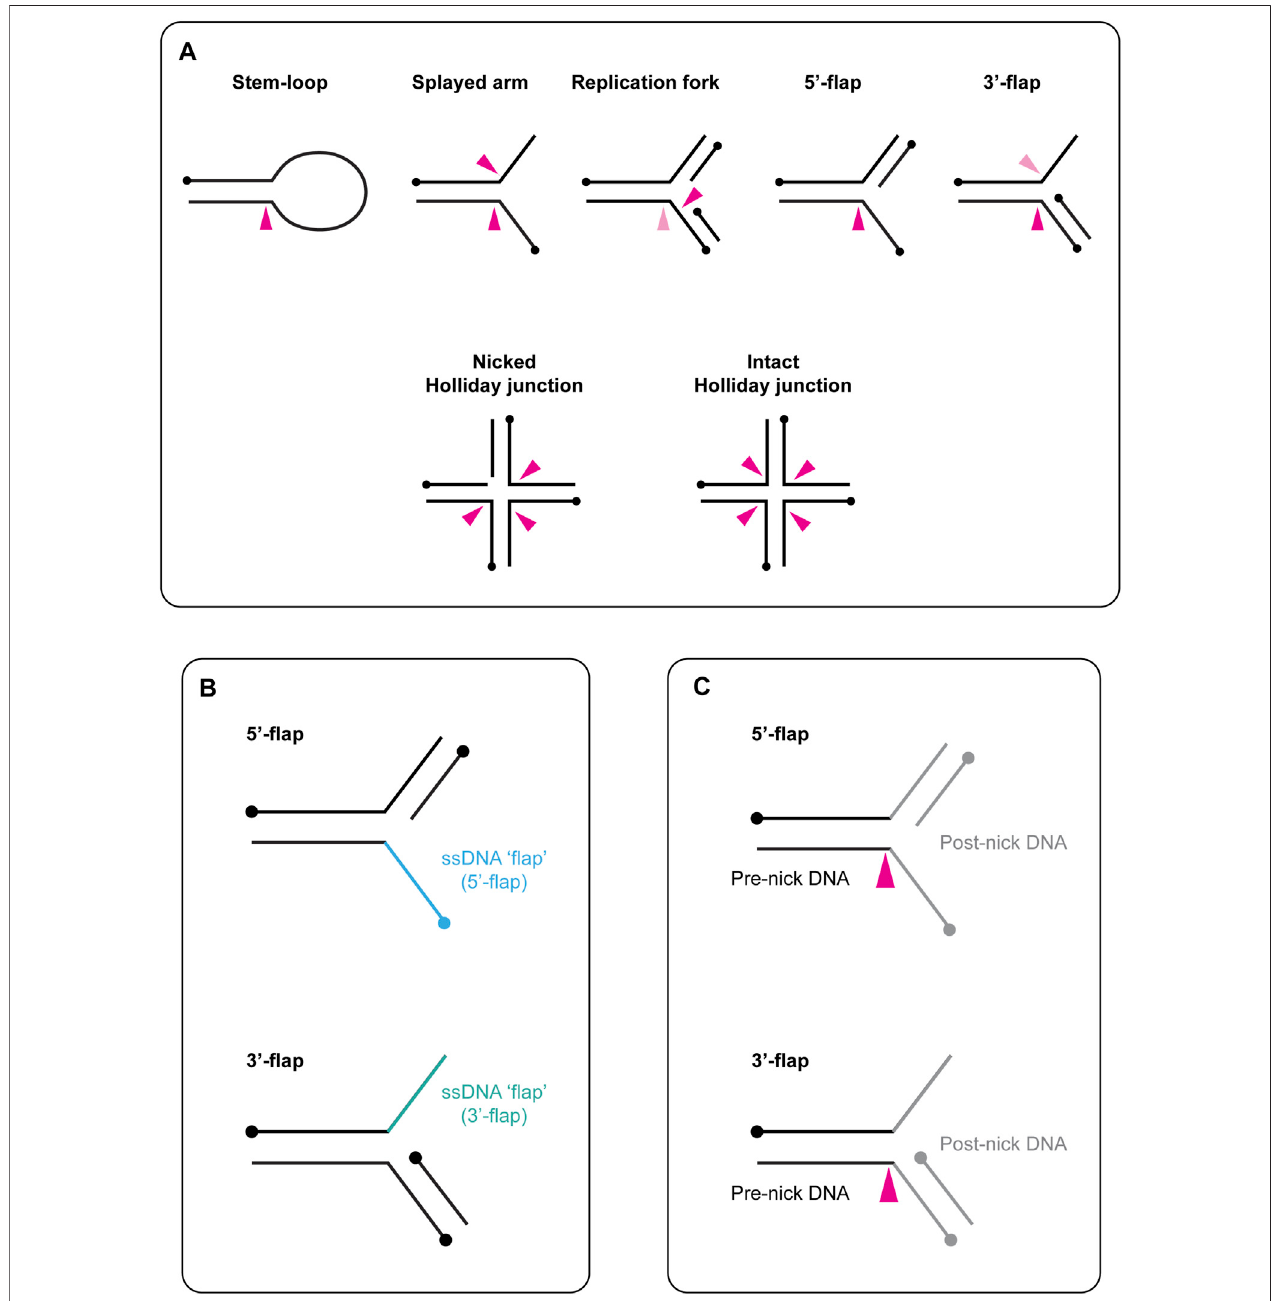
FIGURE1|(A) SchematicrepresentationofbranchedDNAstructuresthatarecleaved invitro byyeastSlx1-Slx4andhumanSLX1-SLX4.Blackcirclesindicate5 ′ - termini.ApinkarrowindicatestheapproximatesitesofcleavagewithineachDNAstructure,withadarkpinkarrowrepresentingthepredominatecleavagesiteandalight pinkarrowrepresentingtheminorcleavagesite.Whenmultiplearrowsareshown,eacharrowrepresentsonepossiblecutsite. (B) Graphicaldescriptionof fl appedDNA structures. The single-stranded DNA (ssDNA) is referred to as the fl ap and is shown in blue (5 ′ - fl ap, top) or green (3 ′ - fl ap, bottom). The name of the DNA substrate re fl ects thepolarity ofthe fl ap: the ssDNA runs3 ′ to5 ′ in the5 ′ - fl ap (top) and 5 ′ to3 ′ in the3 ′ - fl ap (bottom) . Circles indicate 5 ′ -termini. (C) Schematic representation of the terms pre-nickand post-nick,which areused todistinguish betweenthe twodouble-stranded segments ofDNA that fl anktheincision site. Blacklines representthe double-strandedDNAupstreamoftheincisionsite(pre-nick),whereasgreylinesrepresentthedouble-strandedDNAdownstreamoftheincisionsite(post-nick).Circles indicate 5 ′ -termini. A pink arrow indicates the approximate sites of cleavage within each DNA structure.